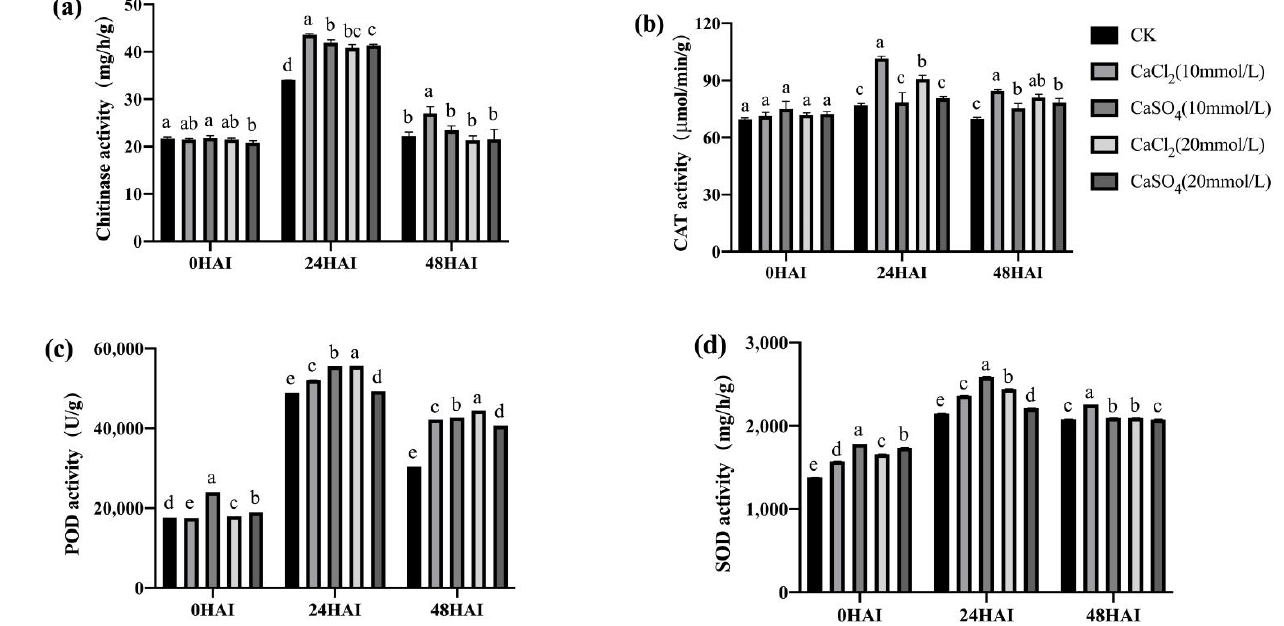
Figure 13. Exogenous Ca 2+ enhanced the activities of chitinase ( a ), CAT ( b ), POD ( c ), and SOD ( d ) in high-vigor maize seeds under F. graminearum infection. HAI, hours after inoculation. Different letters indicate significant differences among different lines (Tukey’s test).